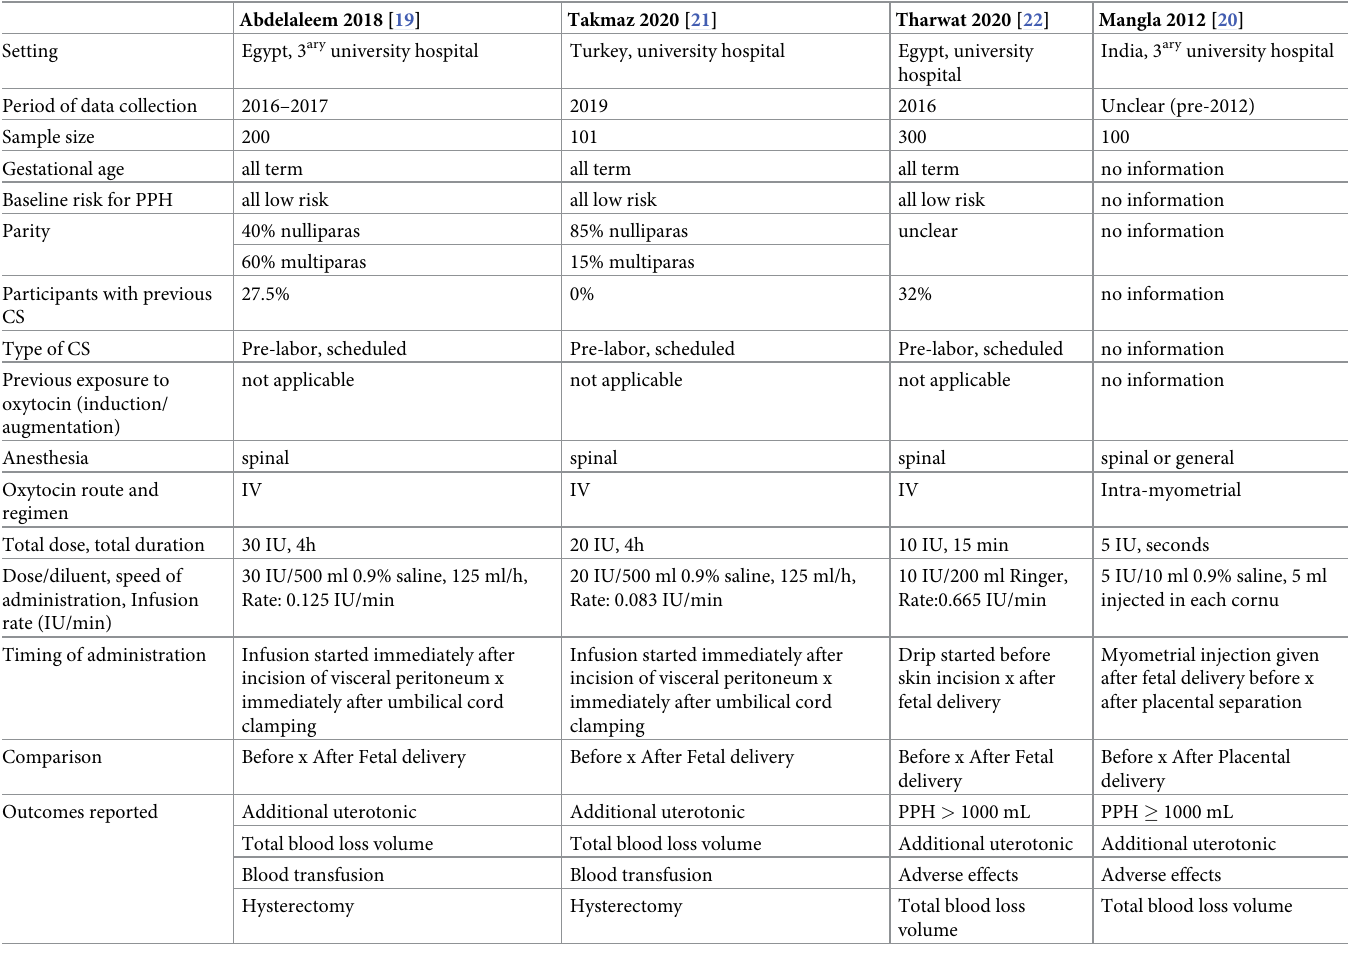
Table 1. Main characteristics of trials on timing of oxytocin administration at